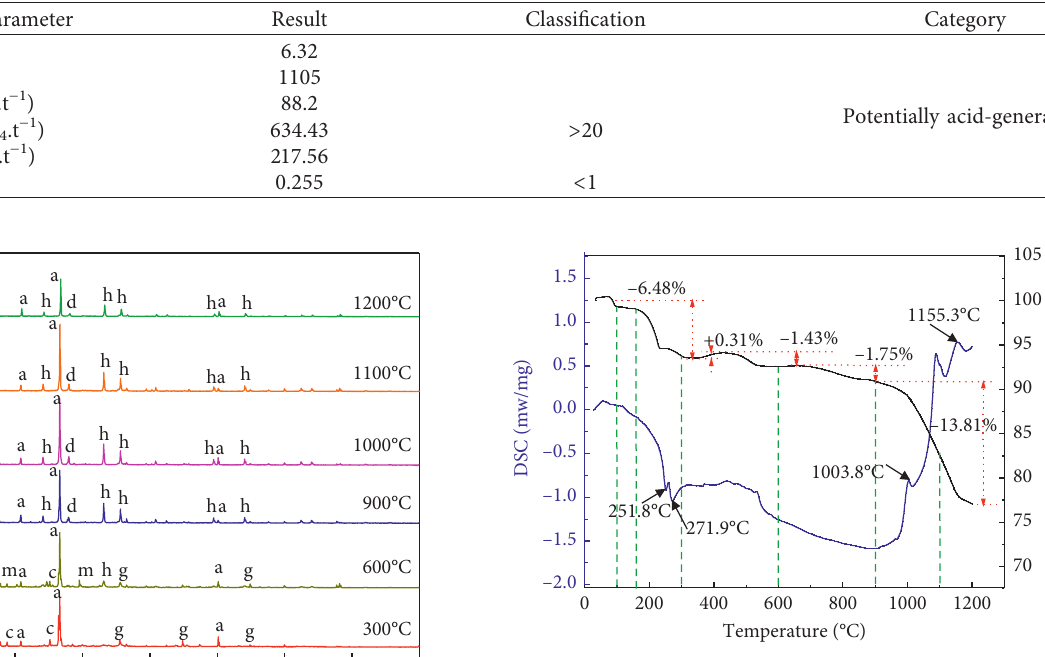
Figure 5: TG and DSC curves for copper tailings heated at 10 ° C min − 1 in